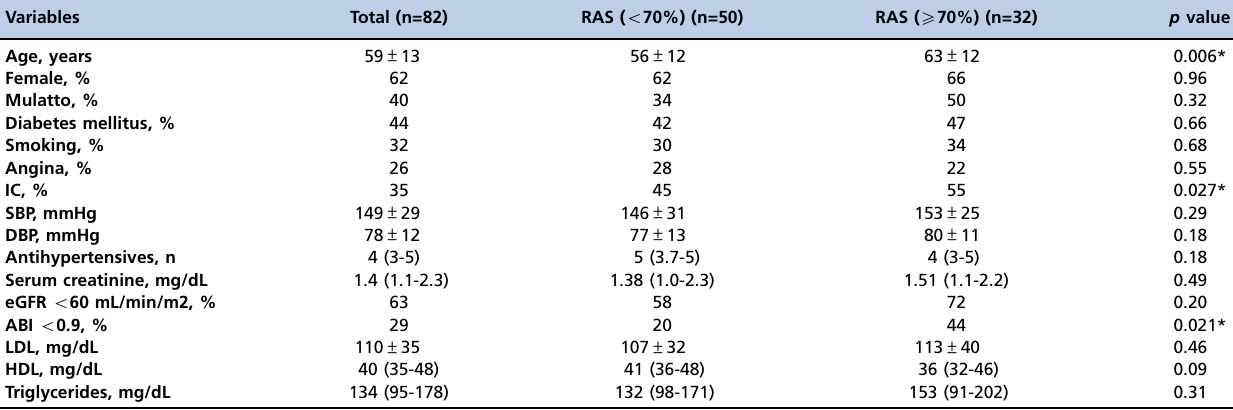
Table 1 - Clinical characteristics of the 82 patients according to the presence of severe renal artery stenosis. Variables Total